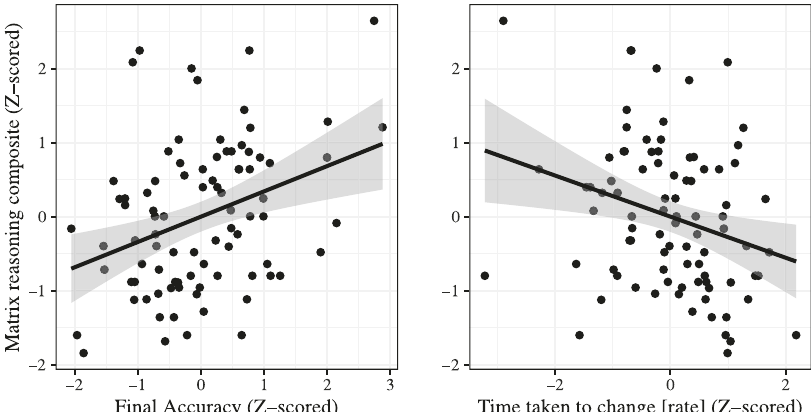
Fig. 2 Correlations between Gf and two components of participants ’ working memory trajectories. Components were the fi nal accuracy ( r = 0.33, BF log3 = 2.99) and rate of change ( r = − 0.30, BF log3 = 2.05). Shaded area indicates 95%